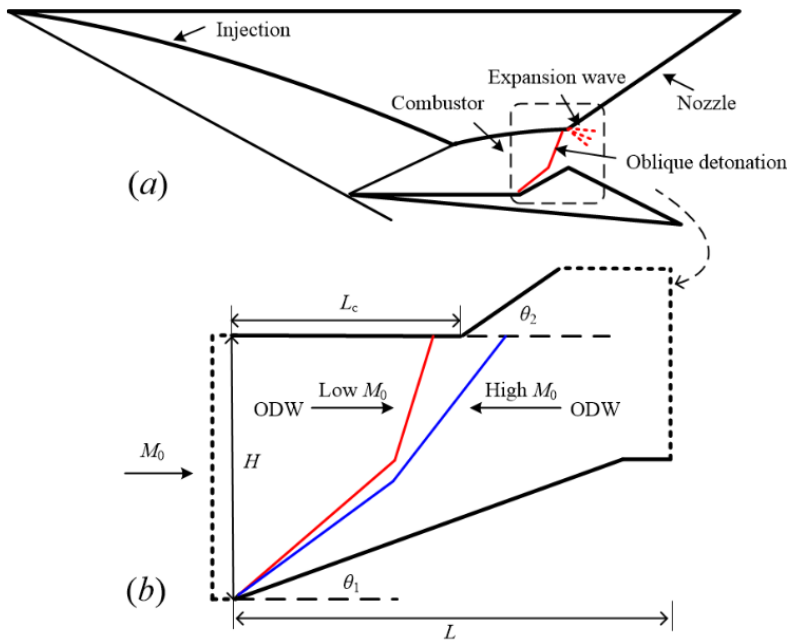
Figure 1. ( a ) Schematics of the oblique detonation engine and ( b ) the computational model of the combustor.